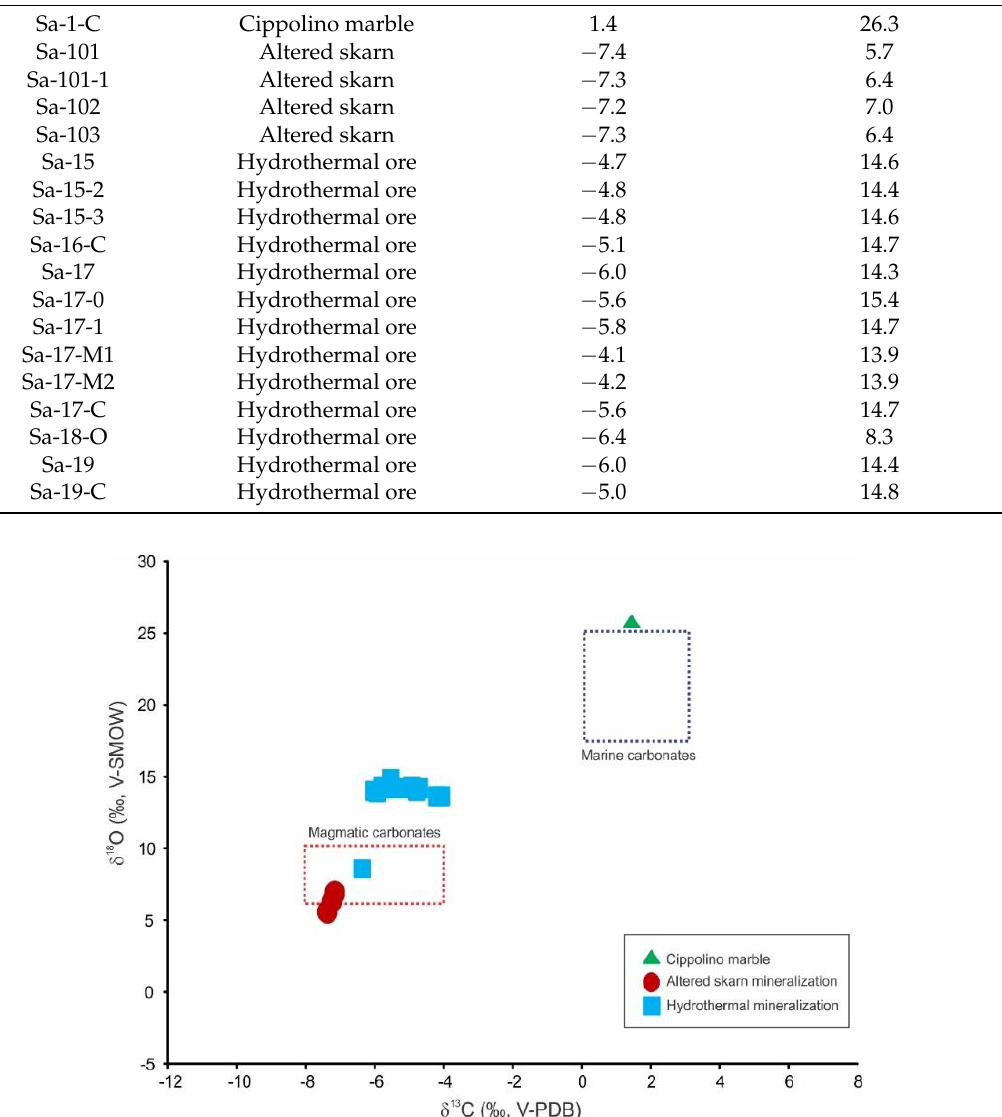
Figure 13. δ 13 C vs. δ 18 O plot of different generations of carbonates from the Sasa Pb-Zn-Ag skarn deposit. Reference values for marine carbonates reference values for magmatic carbonates from [51] and [52].